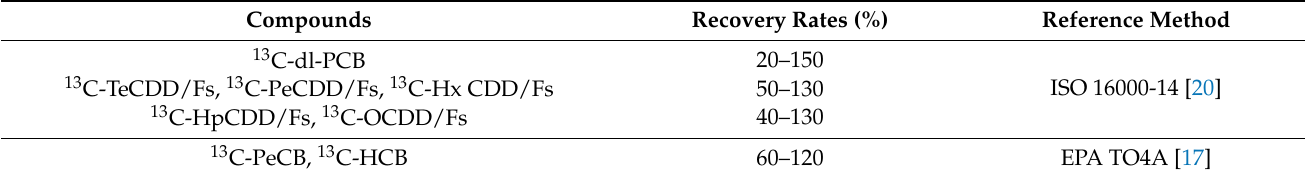
Table 1. Method precision is determined by %RSD for each tested technique and is based on triplicate tests. The criterion of acceptance is <15%.